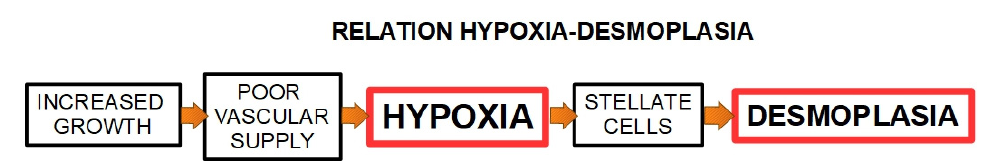
Figure 6. Schematic representation of the relationship between hypoxia and